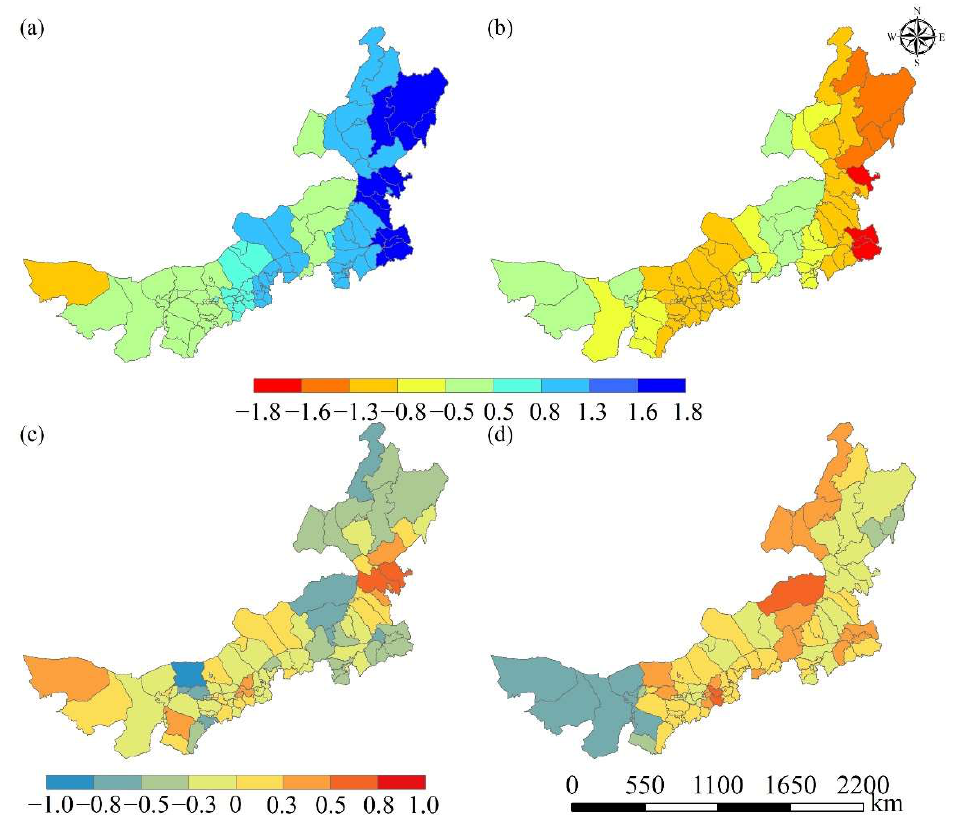
Figure 10. The distribution of SWEI in winter of 2000, 2003 and correlation between SWEI and small livestock population. ( a , b ) SWEI in winter of 2000 and 2003; ( c , d ) Correlation between SWEI and small livestock population in winter of 2000 and 2003.